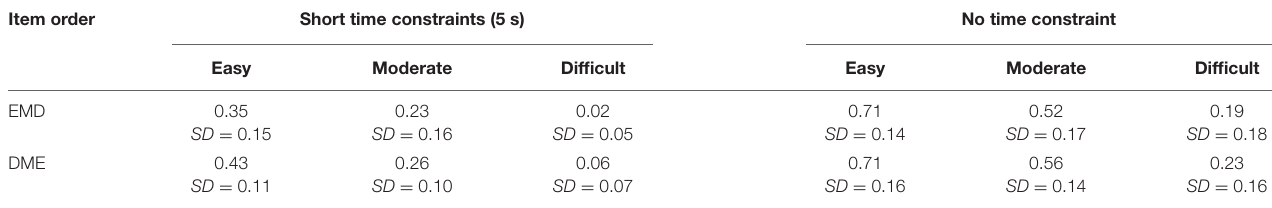
TABLE 4 | Test accuracies for Experiment 2 (Ms,